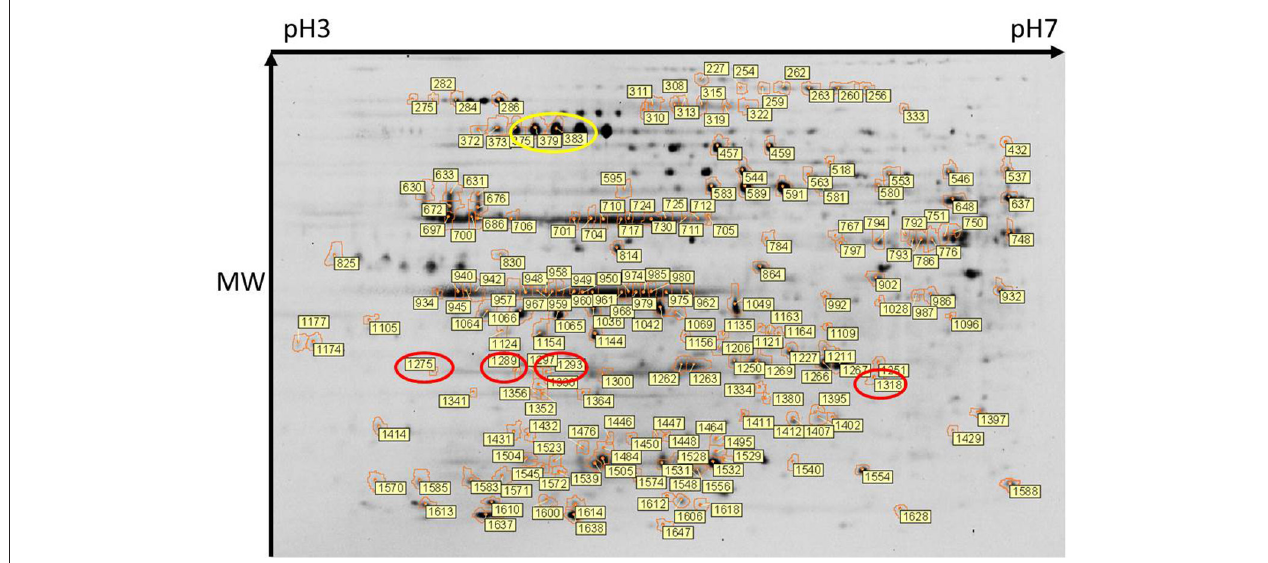
FIGURE 1 | Two-dimensional gel electrophoresis of leptospires. Composite image of protein spots detected across all 9 gels and in which 1735 protein spots were aligned. Of these, 202 protein spots were determined to be differentially expressed (DE) ( p < 0.05). DE protein spots, and their identifier (as listed in Supplementary Tables 1 , 2 ) are indicated. Protein isoforms of the differentially expressed Loa22 and GroEL are circled in red and yellow respectively. An unmarked version of the stained gel is presented in Supplementary Figure 1 .